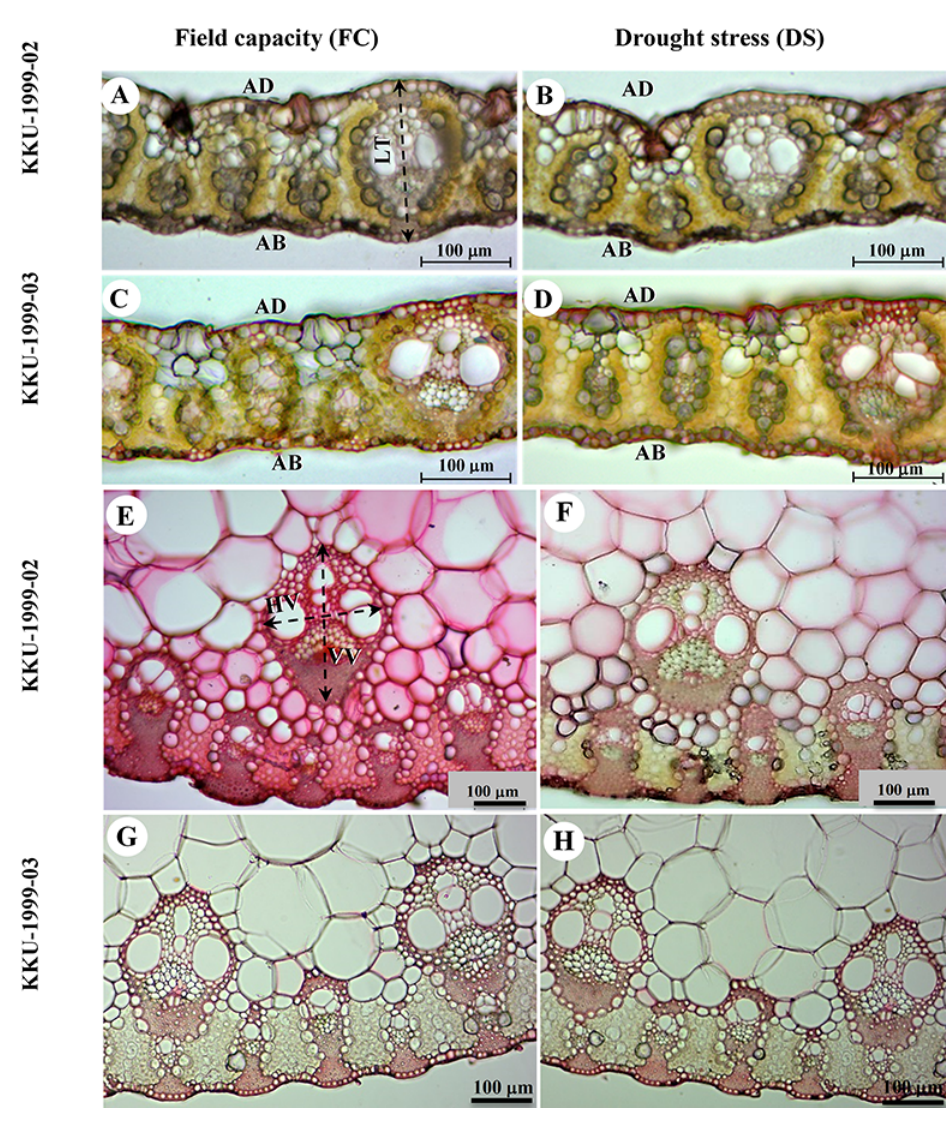
Figure 2 Sugarcane leaf transversal sections – lamina ( A–D ) and midrib ( E–H ) – displaying leaf blade thickness and vascular bundle size of KKU-1999-02 ( A,B,E,F ) and KKU-1999-03 ( C,D,G,H ) cultivars for field capacity (FC) and drought stress (DS) treatments from 30 to 90 days. ( A–D ) Leaf transversal sections; in ( A ): leaf thickness (LT) between adaxial (AD) and abaxial (AB) side. ( E–G ) Vascular bundle size; in ( E ): major vascular bundle size in vertical size (VV) and horizontal size